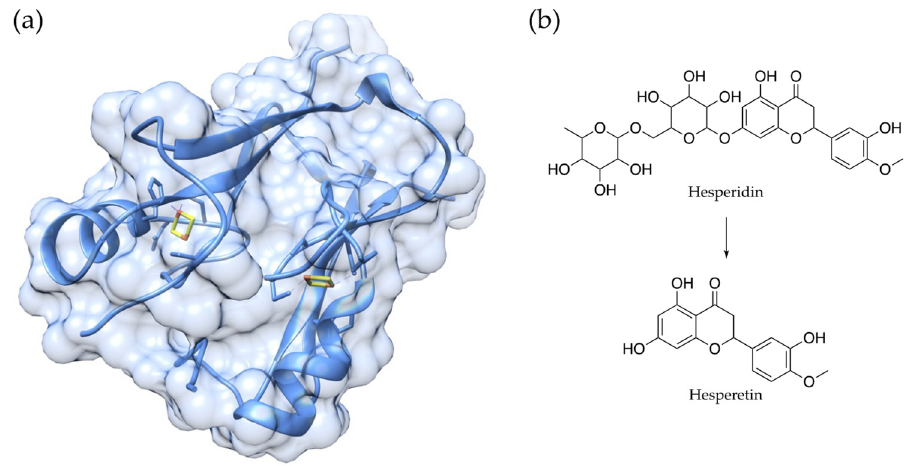
Figure 3. Three-dimensional structure of Miner1 ( a ), encoded by the CISD2 gene (PDB ID 3FNV), and chemical structures of the natural compound hesperidin, and its derivative hesperetin ( b ), the latter of which has been shown to interfere with gene expression and promote rejuvenation.